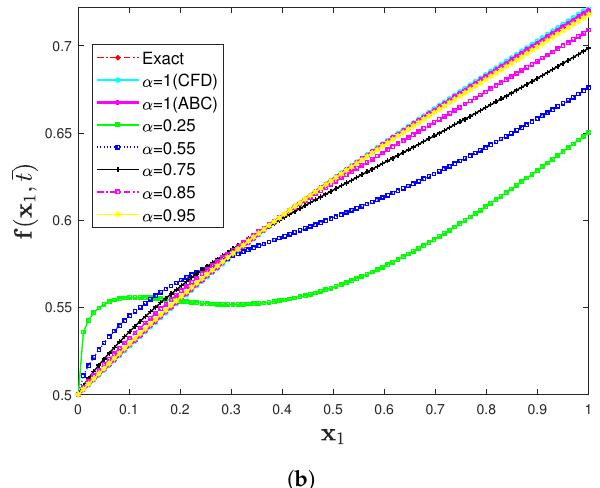
Figure 12. ( a ) Three-dimensional comparison plot among exact, CFD, and ABC fractional derivative operators via the IETM. ( b ) Two dimensional representation of f ( x 1 , ¯ t ) for Problem 4 at different fractional orders when the parameters are θ = 1, β = 1, and ϕ =